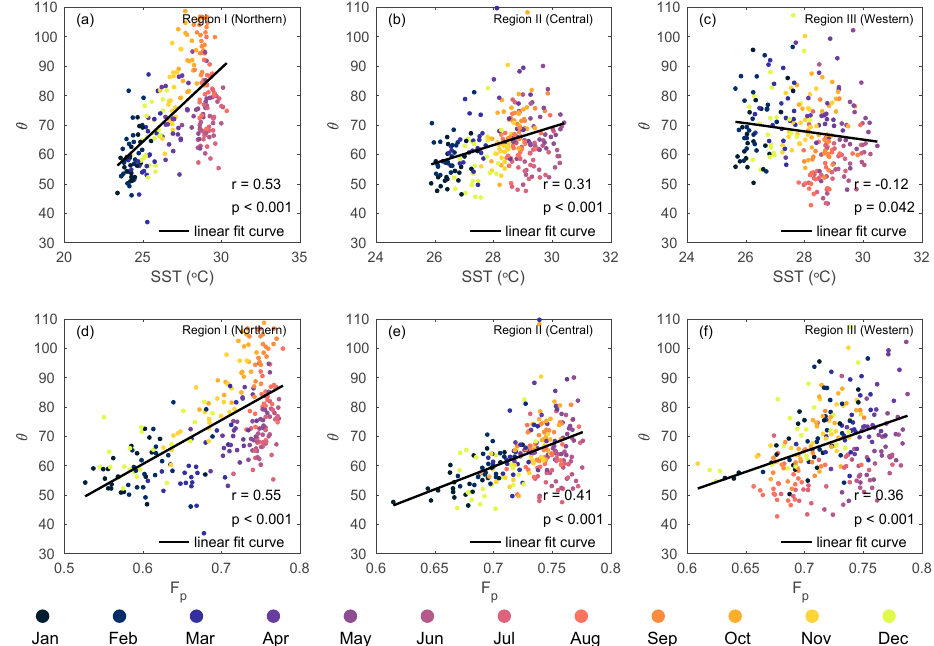
Figure 10. Monthly mean θ as a function of sea surface temperature (SST) and F p . ( a , d ) Region I, ( b , e ) Region II, ( c , f ) Region III. The solid line represents a linear fit to OC-CCI data